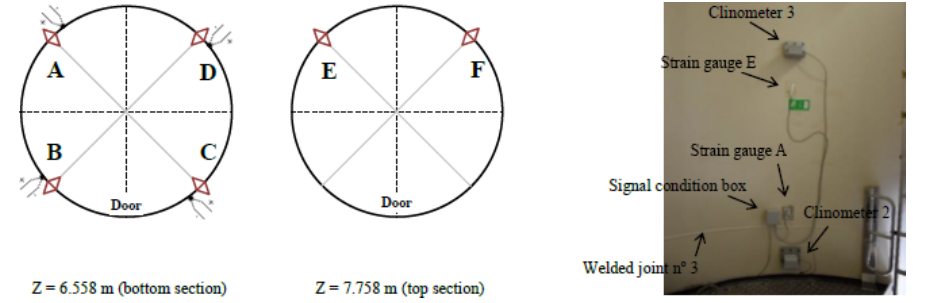
) and temperature sensors ( ) and photograph of the position of the clinometers and strain Figure 11. Locations of the strain gauges ( gauges along the same vertical alignment (strain gauges A and E). (cid:51)